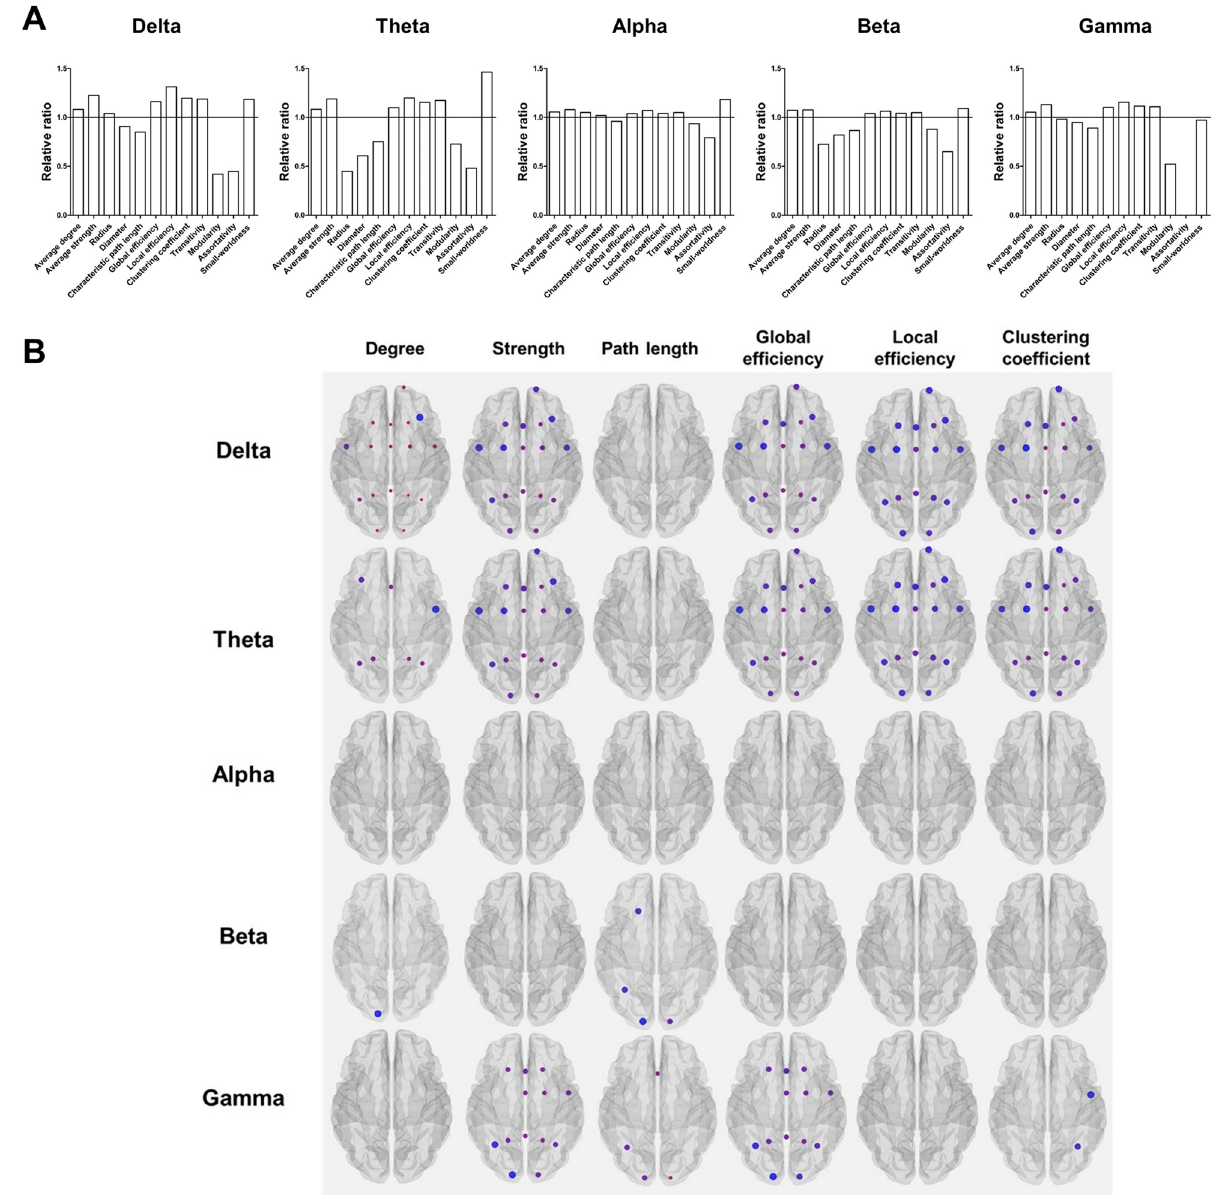
Figure 5. Results of graph-theoretic analyses and correlation analysis. ( A ) By setting the values of graph measures at baseline to 1.0 (shown as a line at the value of 1.0), the relative ratio of global graph measures after coffee consumption are presented. ( B ) Changes after coffee consumption in the nodal measures of graph- theoretic analyses are presented (FDR-corrected P < 0.05). Larger nodes indicate greater differences between the conditions. The regions showing higher significance of differences are colored red, whereas the regions showing lower significance of difference are colored